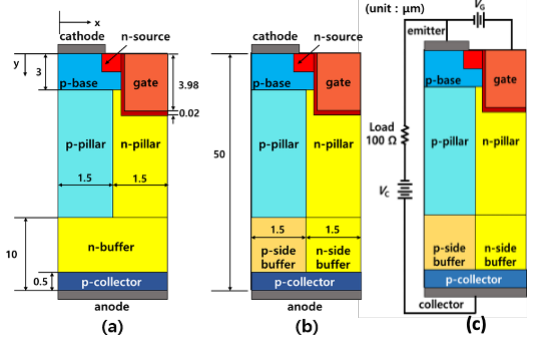
Figure 1. Structure of ( a ) C-SJBT and ( b ) proposed SJBT with separated n-buffer layers (SB-SJBT). ( c ) Circuit diagram for measuring turn-off loss.